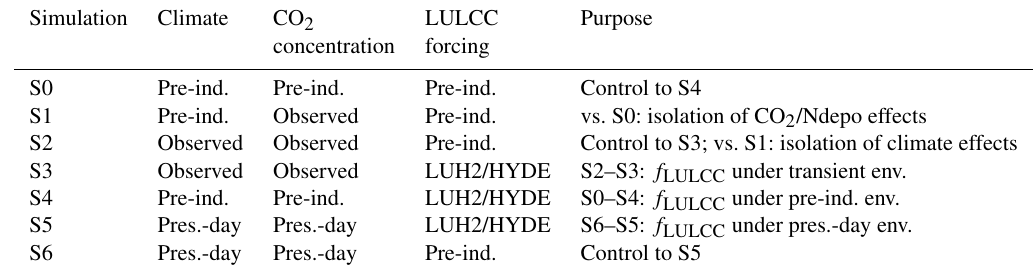
Table 1. Overview of the simulations used in our study comprising transient (observed historical evolution), pre-industrial or present-day (constant) forcing for environmental conditions (such as climate and atmospheric CO 2 concentrations), and transient or fixed pre-industrial land use and cover distribution (with an additional description of their purpose of use). For the underlying forcing data and protocol, refer to Friedlingstein et al. (2019). All runs were performed within the TRENDY v8 efforts for the GCB2019.